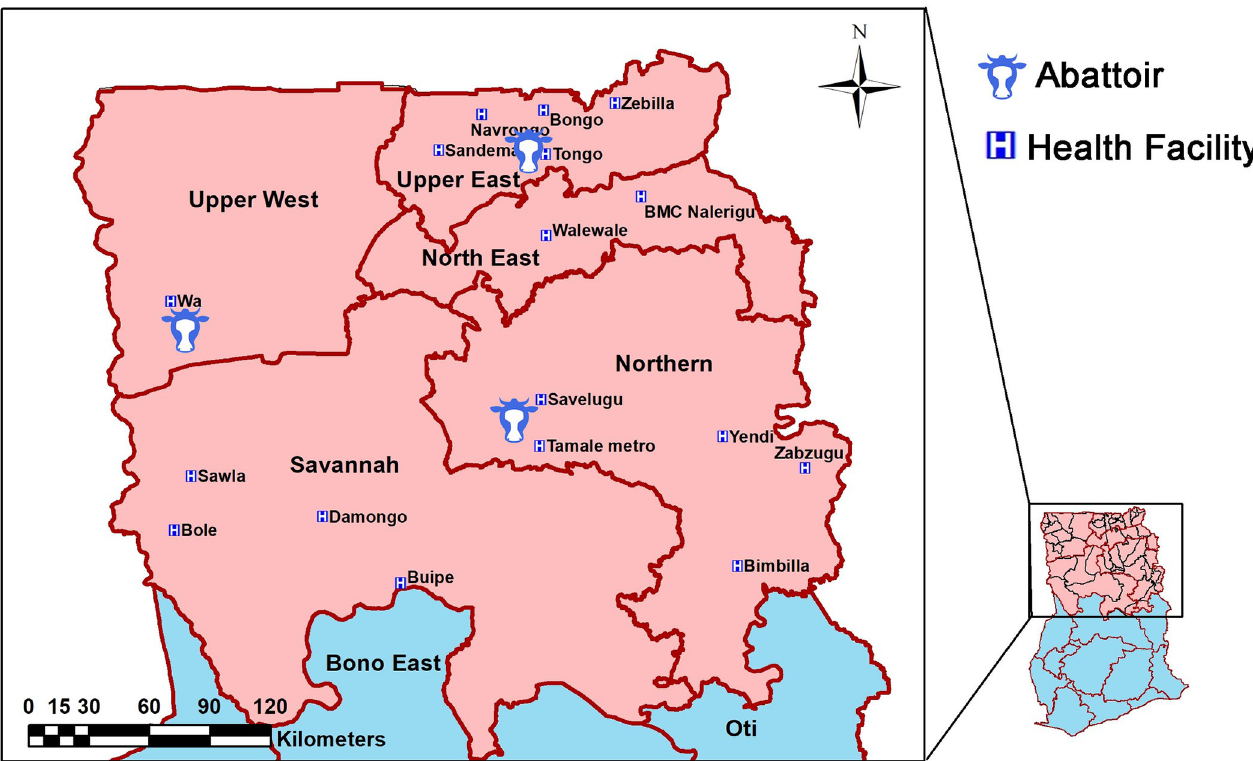
Fig 1. Study area and sampling sites. The base map as well as the copyright information for use of the base map files can be obtained at https://data.humdata. org/dataset/cod-ab-gha. No changes were made to the base map files.